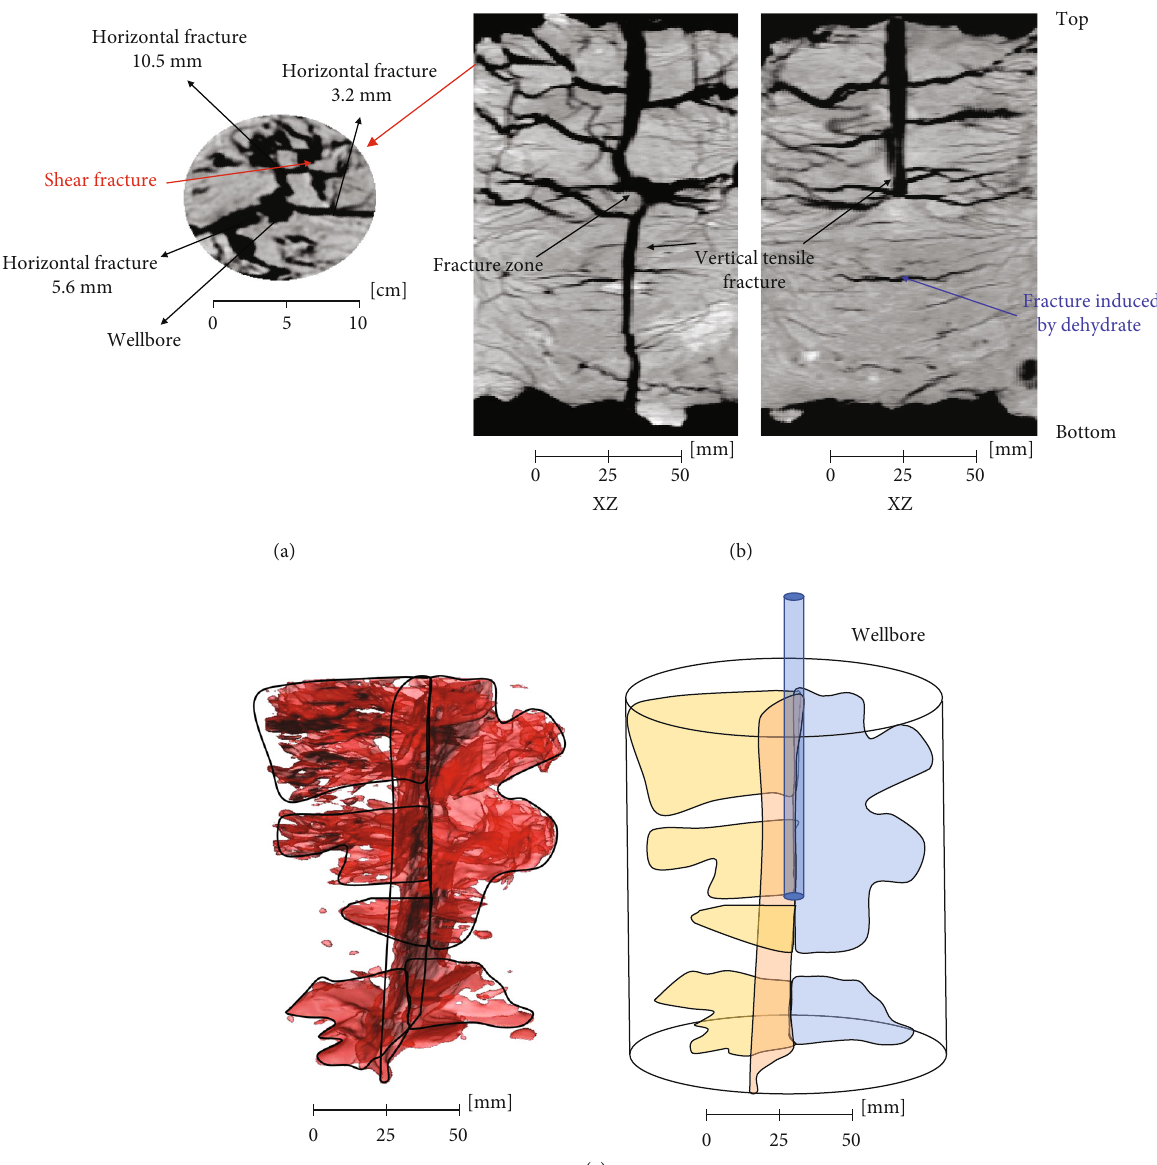
Figure 10: The fracture characteristics of sample 3 after hydraulic fracturing by CT: (a) CT section image, (b) CT perspective views, and (c) 3D